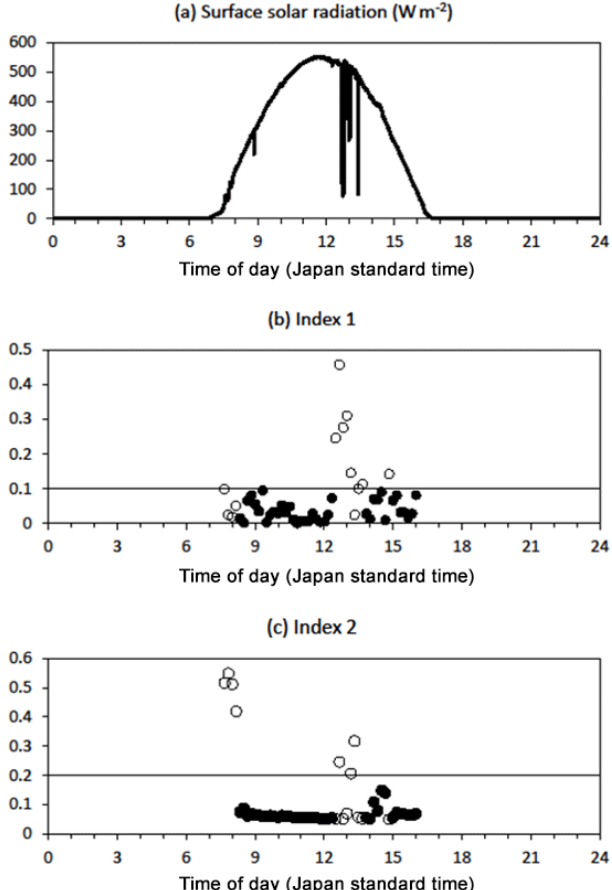
Figure 9. An example result of the SCAD method on 6 January 2014, in Tsukuba. (a) Surface solar radiation observed by the pyra- nometer. (b) Index 1. (c) Index 2. The closed circles indicate clear- sky conditions, and the open circles indicate cloudy conditions (b, c) . The lines at 0.1 in (b) and 0.2 in (c) are thresholds for in- dexes 1 and 2,